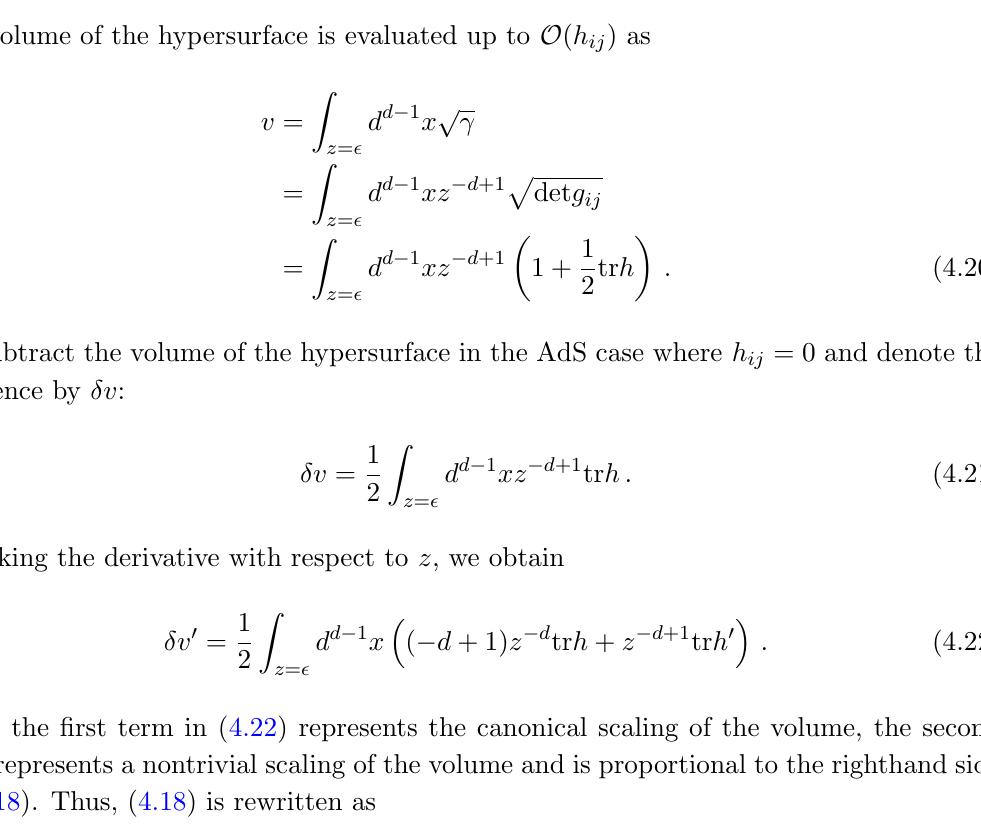
Figure 1 . A red line represents a codimension-2